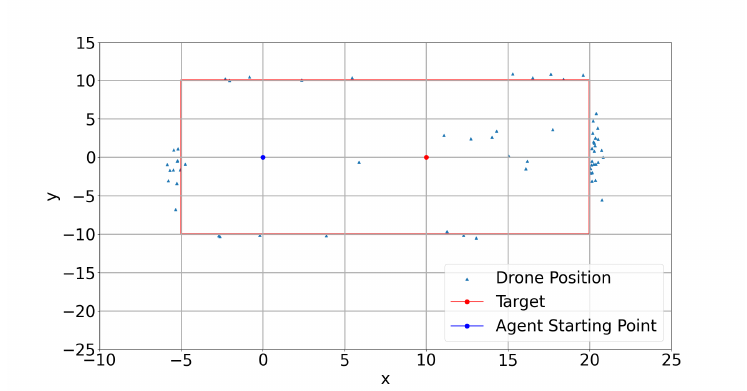
Figure 18. DQfD Crash Positions.